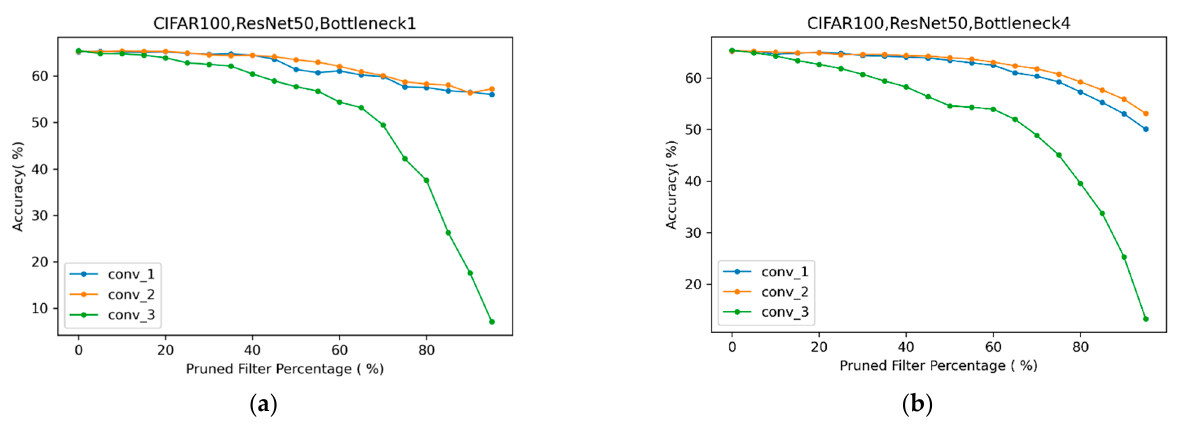
Figure 11. The accuracy of different pruning percentages. The third convolution layer in the Bottleneck of ResNet50 is too sensitive to prune. Subfigures ( a , b ) show different Bottlenecks in ResNet50, and both third convolutional layers are sensitive.